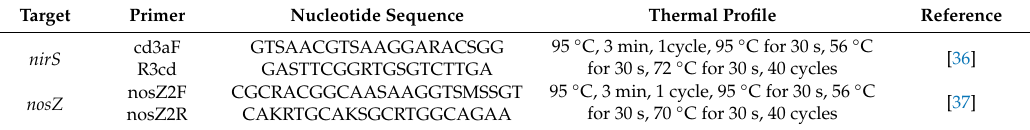
Table 2. Primers, thermal profiles and parameters for qRT-PCR quantification of nirS and nosZ